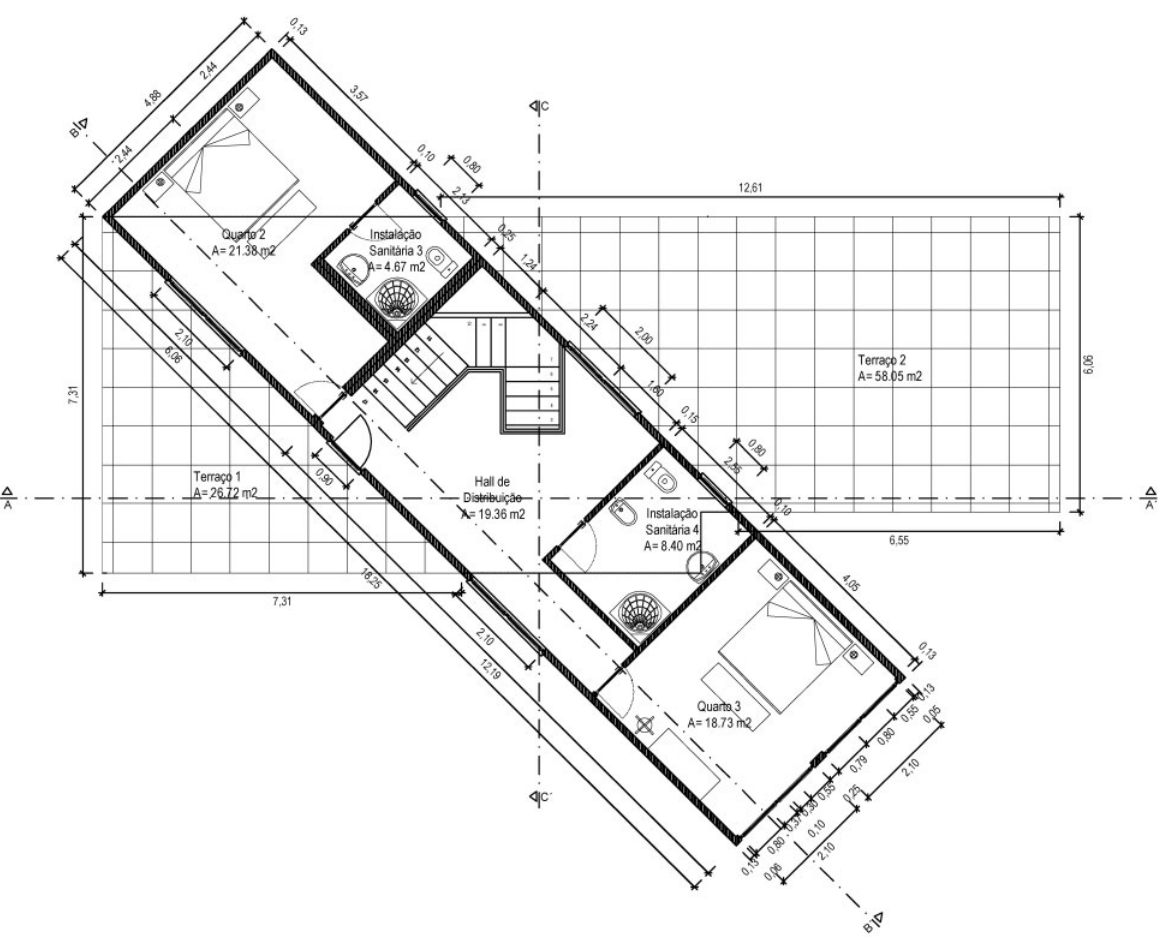
Fig. 10. Single family house: Floor 1